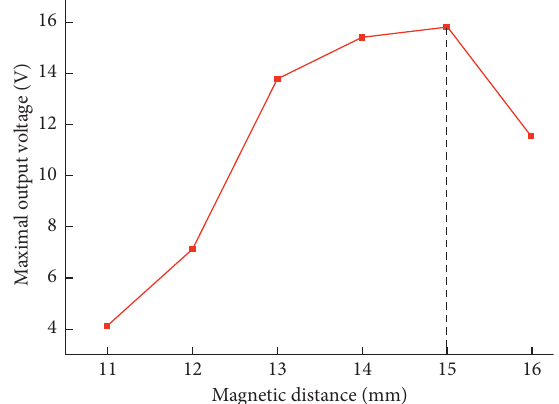
Figure 29: Relation of initial magnetic distances and the maximum output voltage of the structure C.